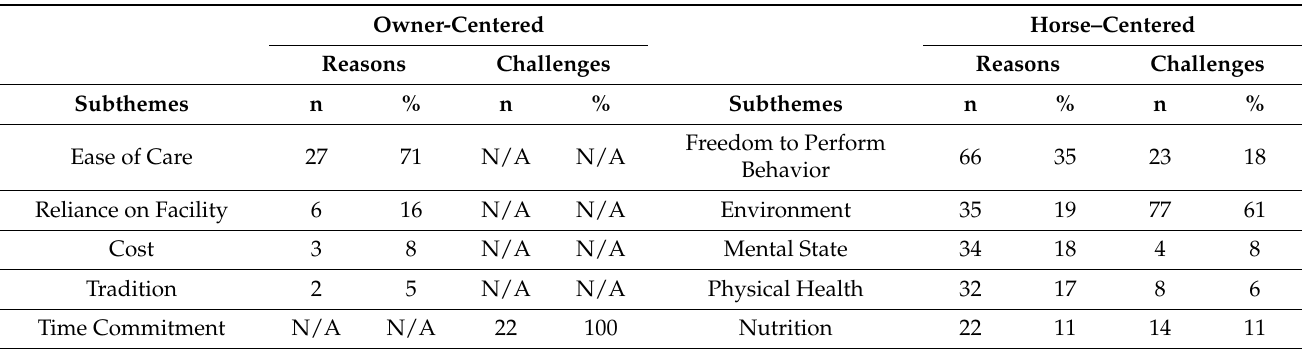
Table 2. Horse owners’ reasons for and challenges with housing horses in their current hous- ing conditions. Responses are categorized by themes based on content analysis of open-ended questionnaire